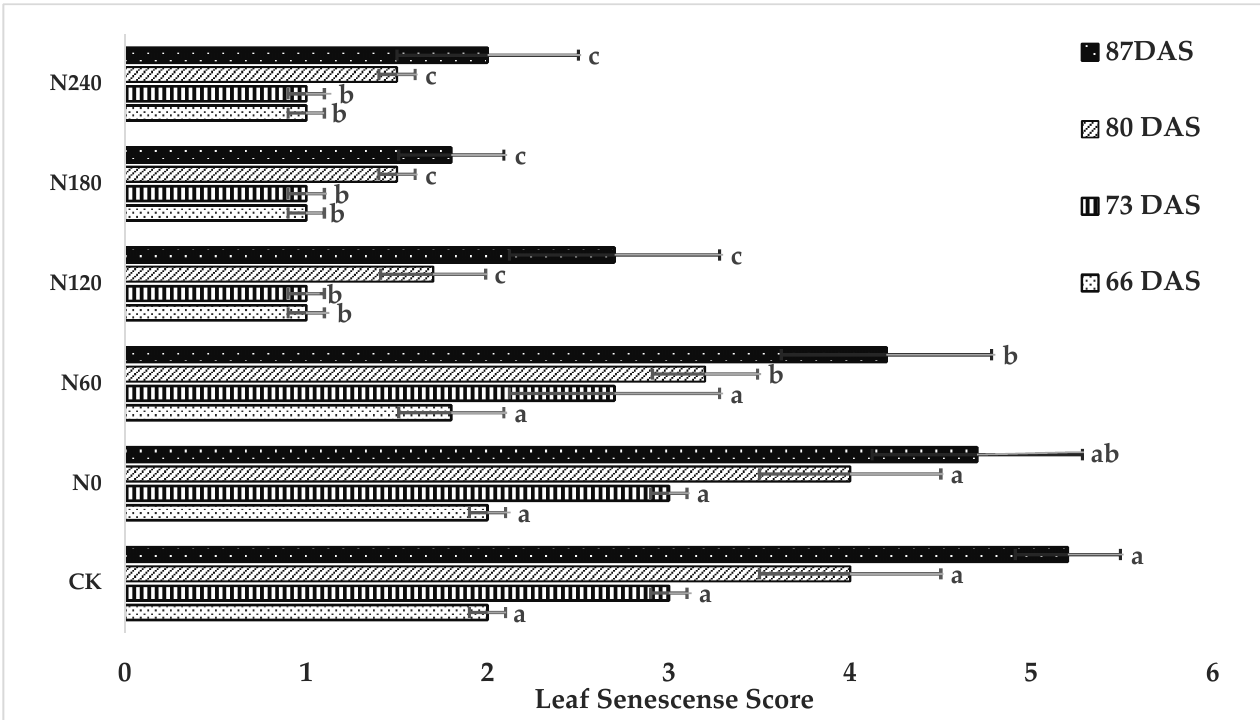
Figure 3. Leaf senescence score in different treatments as influenced by N doses. DAS; days after sowing, CK; control treatment, N0; 0 kg ha −1 N, N60; 60 kg ha −1 N, N120; 120 kg ha −1 N, N180; 180 kg ha −1 N, N240; 240 kg ha −1 N, senescence scores can be converted to % by using a multiplication factor of 10 (Score of 2 indicates 20% dead leaf area). Same letters across the treatments indicate a non-significant effect ( p ≤ 0.05).